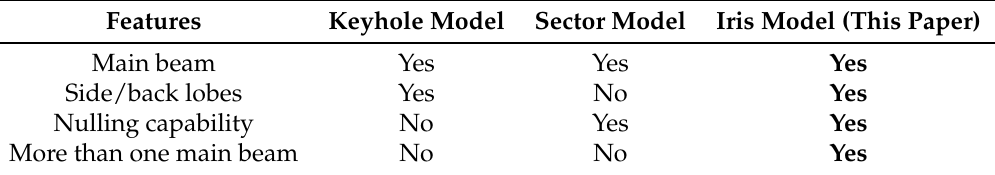
Table 1. Summary of simplified directional antenna